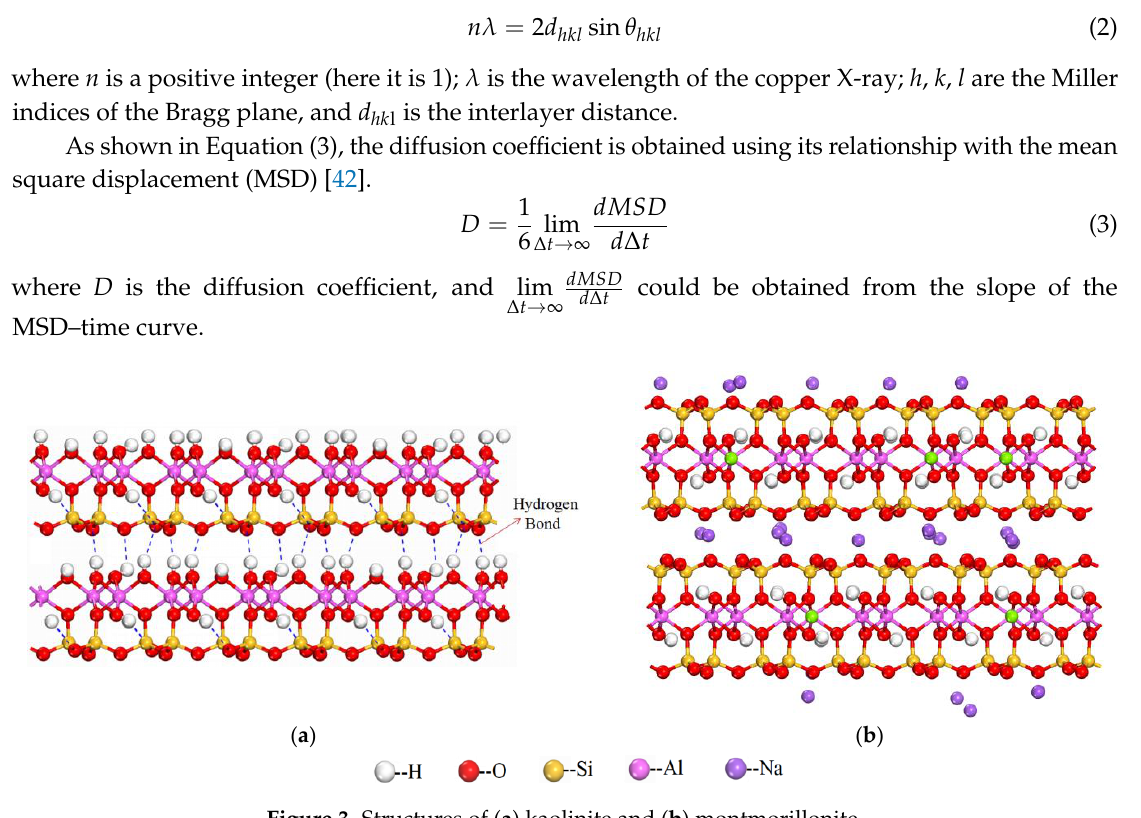
Figure 3. Structures of ( a ) kaolinite and ( b ) montmorillonite.